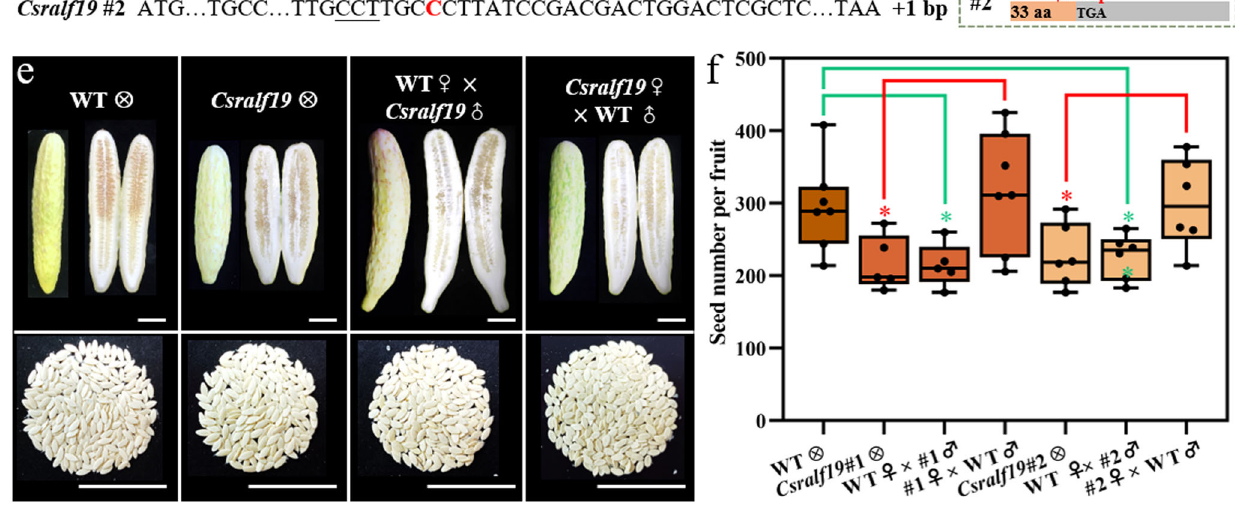
Fig. 4 |Decreasedseed setin Csralf4 and Csralf19 singlemutants. a , d Mutation forms of two homozygous T1 Csralf4 lines ( a ) and two homozygous T1 Csralf19 lines ( d ). Target sequences and PAMs are indicated below the black and red lines, respectively. Deletions/insertions are indicated as red dashes/nucleotides, and deletion/insertion sizes (nucleotides) are marked after the sequence as a minus or plus, respectively. The right dotted box shows the corresponding protein pre- mature termination. The blue/orange boxes indicate CsRALF4/CsRALF19 protein coding region, respectively, and the gray indicates missense sequences resulting